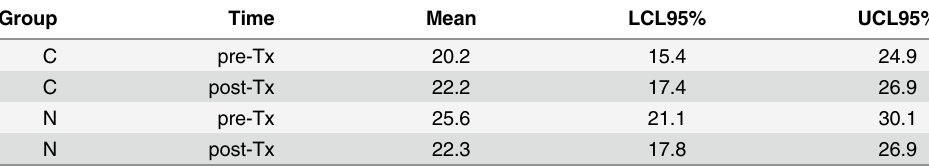
Table 4. Mean pre- and post-Tx UPDRS Total Score.